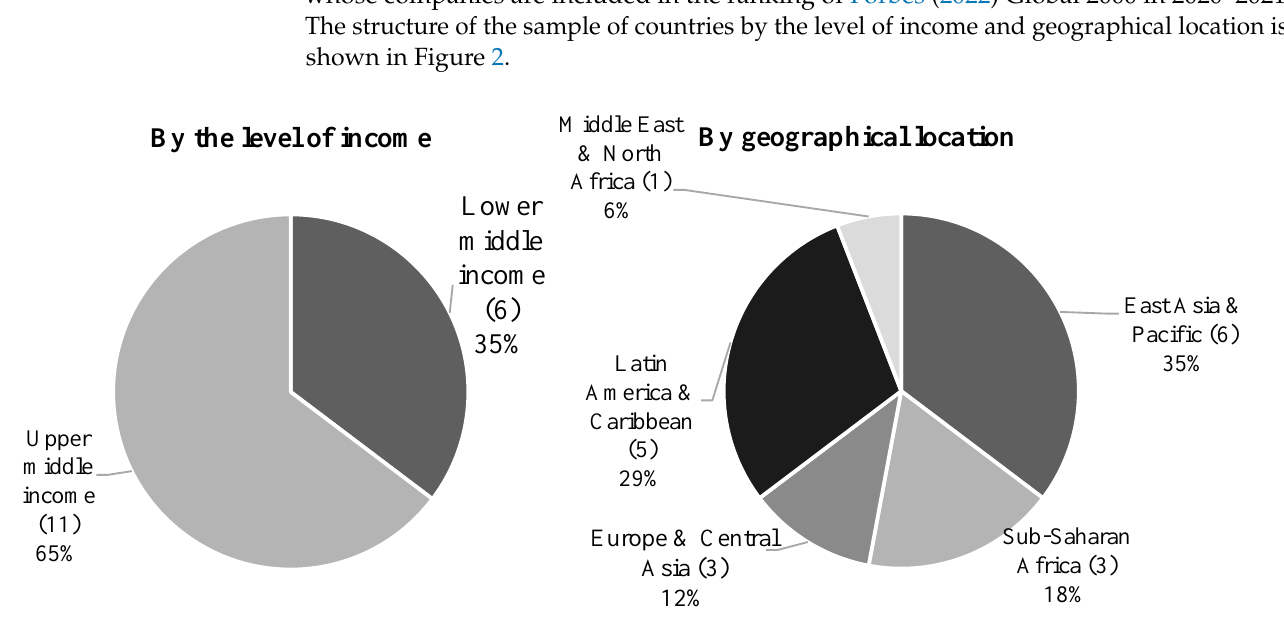
Figure 2. Structure of the sample of countries by the level of income and geographical location. Source: calculated and built by the authors.